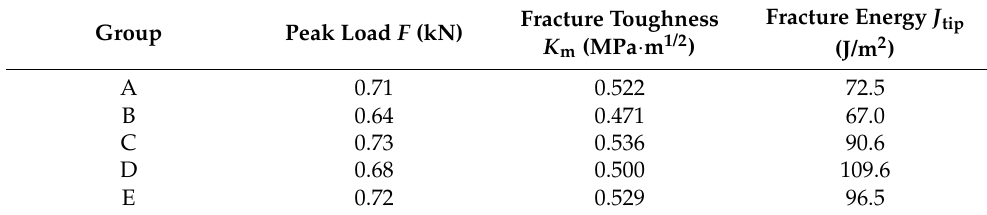
Figure 14. Fracture energy of the cement matrix with different sand particle sizes.